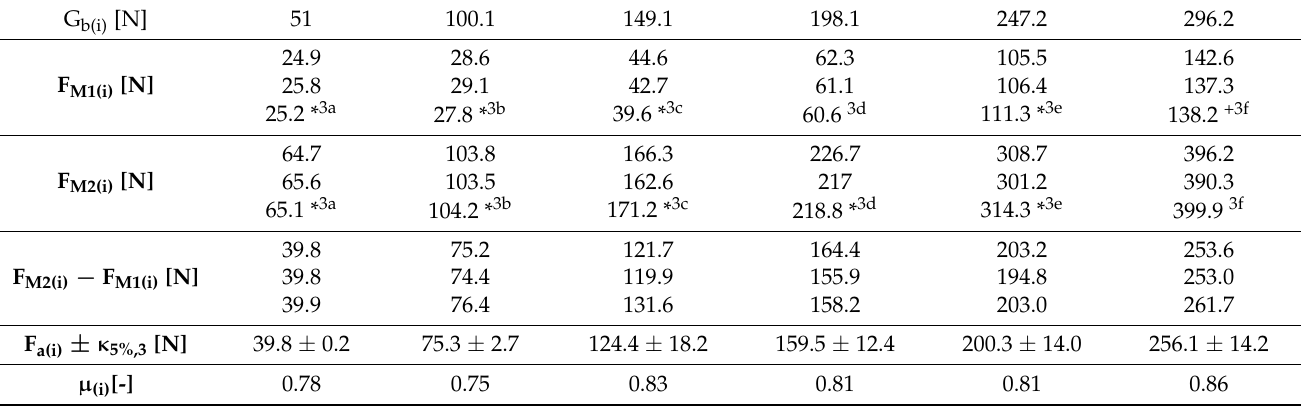
Table 4. Measured force F M1(i) [N] and F M2(i) [N] for the weight of the load G b(i) [N] at angle β = 20 deg.